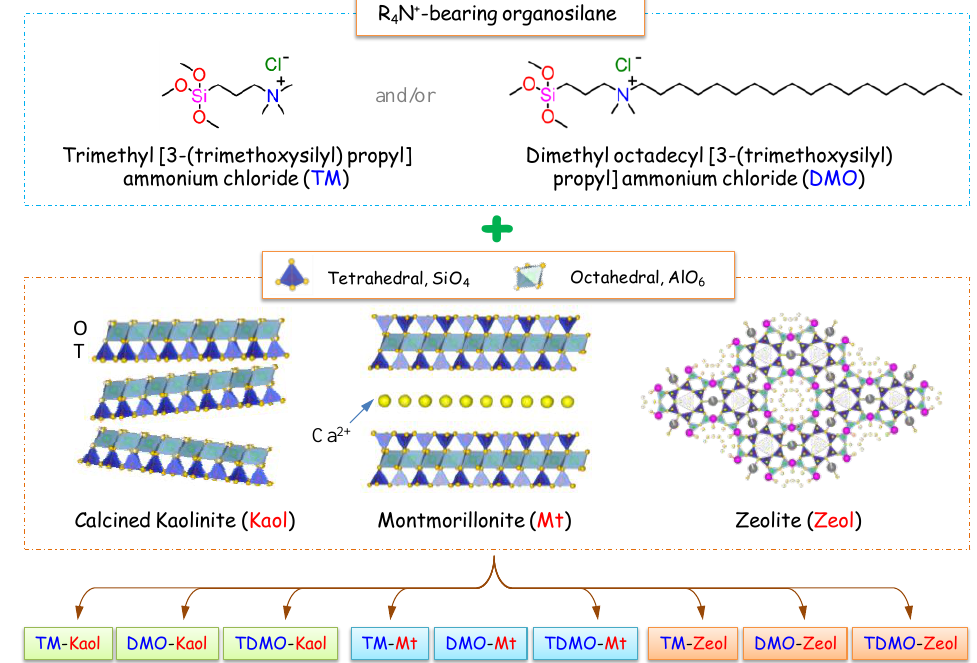
Figure 1. Grafting of the selected aluminosilicate minerals using two R 4 N + -bearing organosilanes.